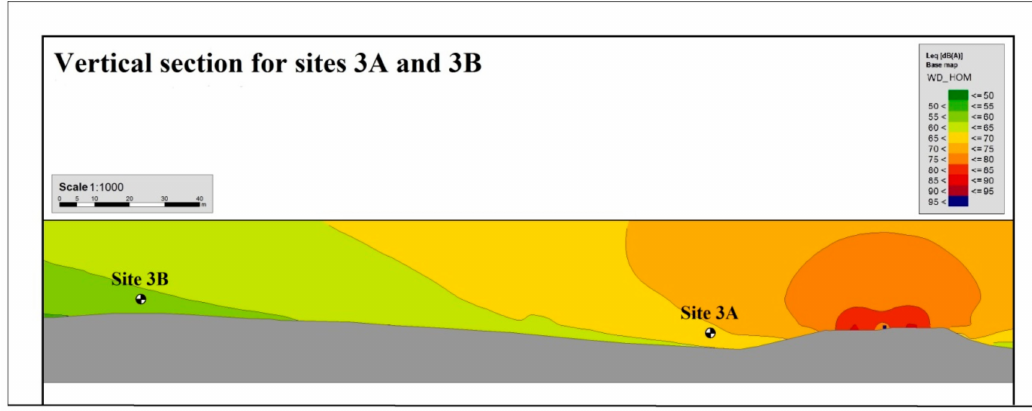
Figure 10. Terrain vertical section corresponding to sites 3A and 3B. Soil characteristics: cultivated field, presence of vegetation barrier, Site 3B in elevated position. Equivalent level intervals are displayed with di ff erent colors. Levels calculated according to the Basic Noise Map